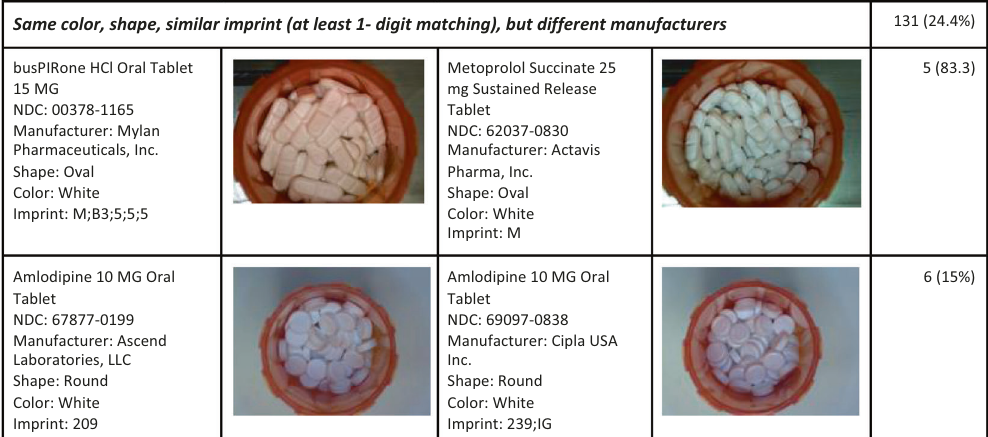
Fig. 4 Frequency of the medication National Drug Code incorrectly predicted by the machine sharing similar characteristics. The left- hand columns show an incorrect National Drug Code (NDC) predicted image along with description of the prescription label. The right-hand columns show an example image of the NDC predicted by the